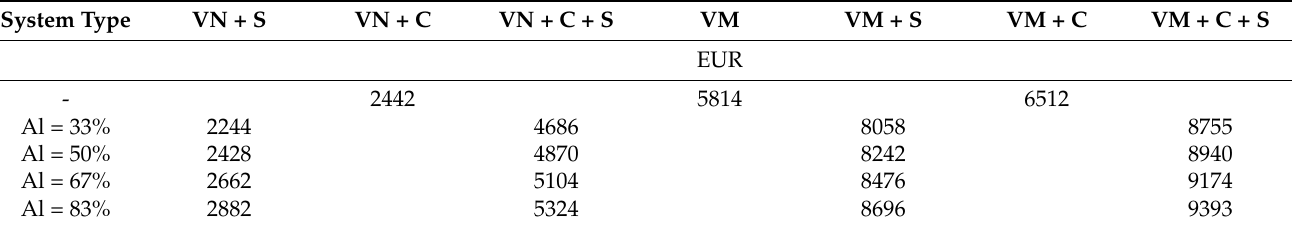
Table 14. Additional